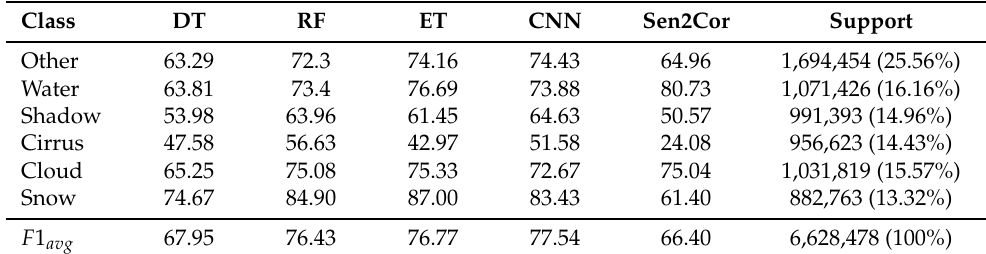
Table 10. Scene Biasness Test Results: F 1 avg values of ML algorithms and